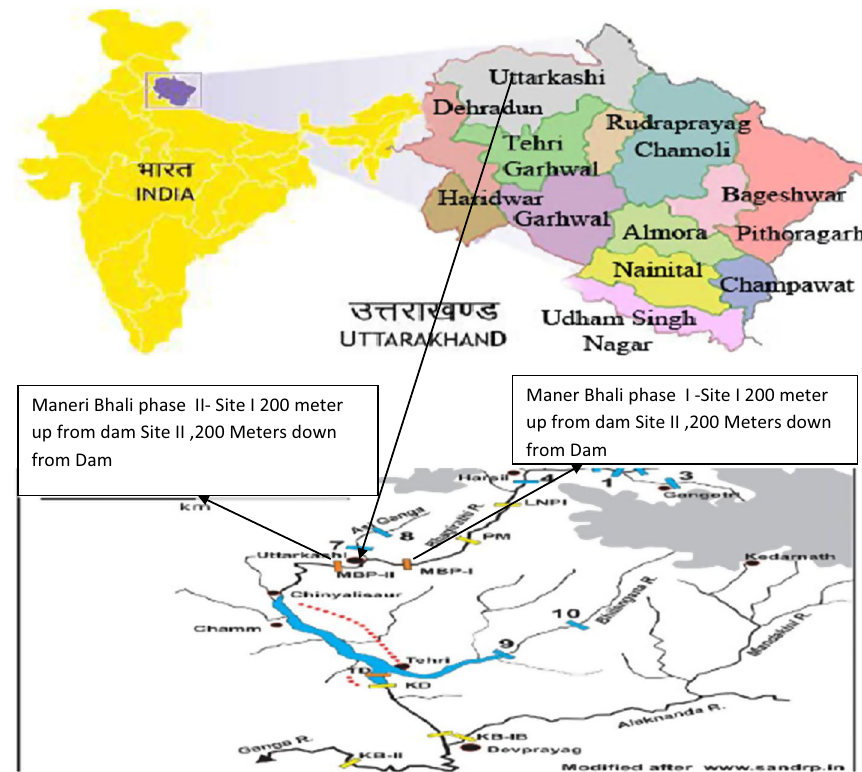
Fig. 1 Network of rivers in Garhwal Himalaya, Uttara- khand. All the major tributar- ies supporting the Ganges are marked in the figure along with study